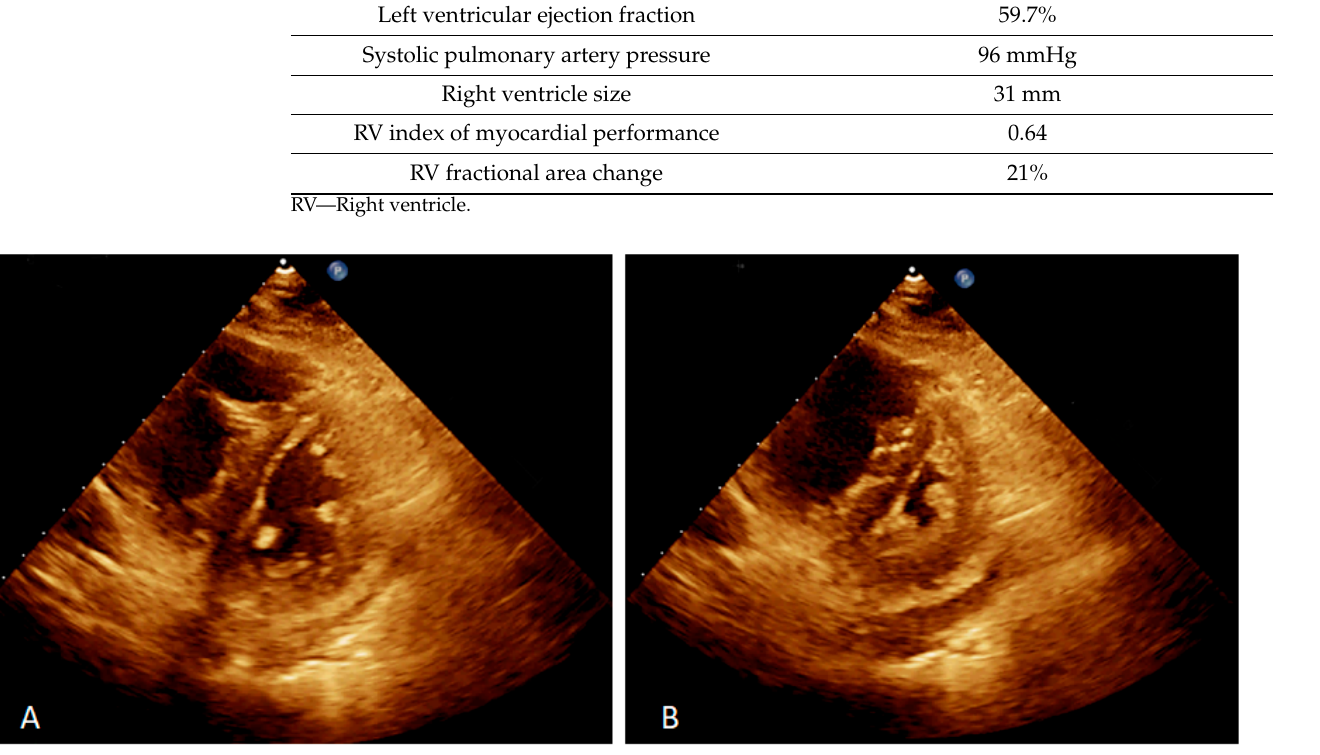
Figure 4. Two-dimensional echocardiography on the parasternal short-axis view showed D-shaped left ventricle during diastole, indicated for fluid overload ( A ) and systole, indicated for pressure overload ( B ).